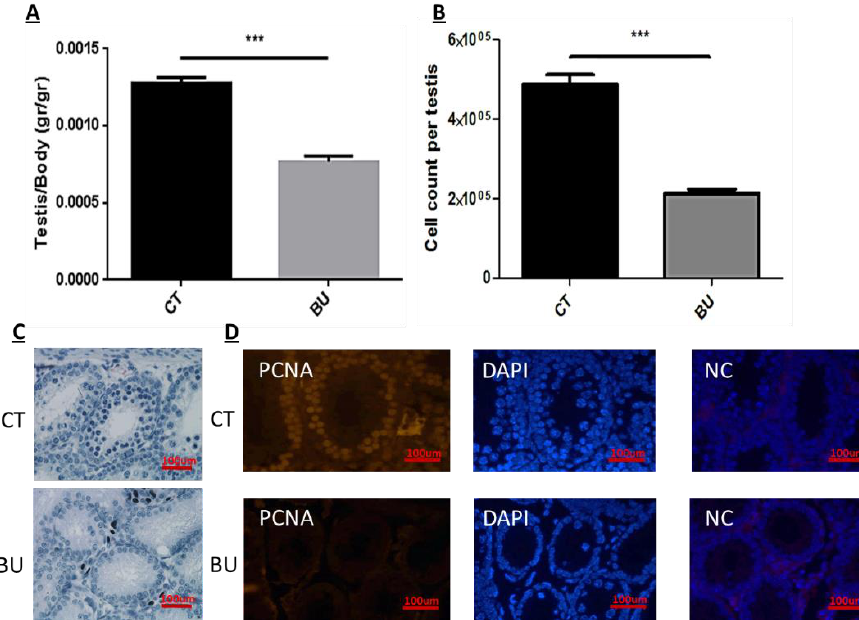
Figure 4 Figure 3. Effect of 10-day post busulfan (BU) treatment on testicular body weight, cell count, and proliferation: BU or dimethyl sulfoxide (DMSO) (control, CT) were i.p injected, as described in Figure 1. Ten days after the injection, the testes were weighed ( A ), the total cells in the seminiferous tubules were counted ( B ), the histology of testicular tissue was examined using hematoxylin and eosin (H&E) staining ( C ), and cell proliferation in testicular tissues was evaluated using proliferating cell nuclear antigen (PCNA) staining ( D ). Negative control (NC) of the tissue is presented. × 40 light microscope magnification (100 µ m scale). *** p <